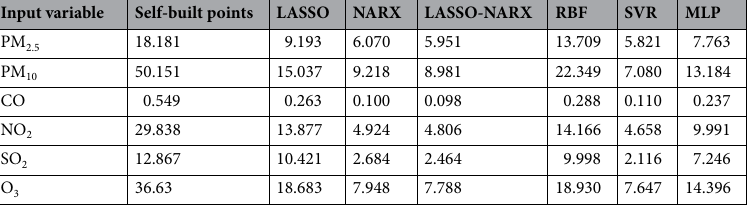
Table 6. MAE of six types of air pollutant concentrations between self-built points, model forecast values and national control point.